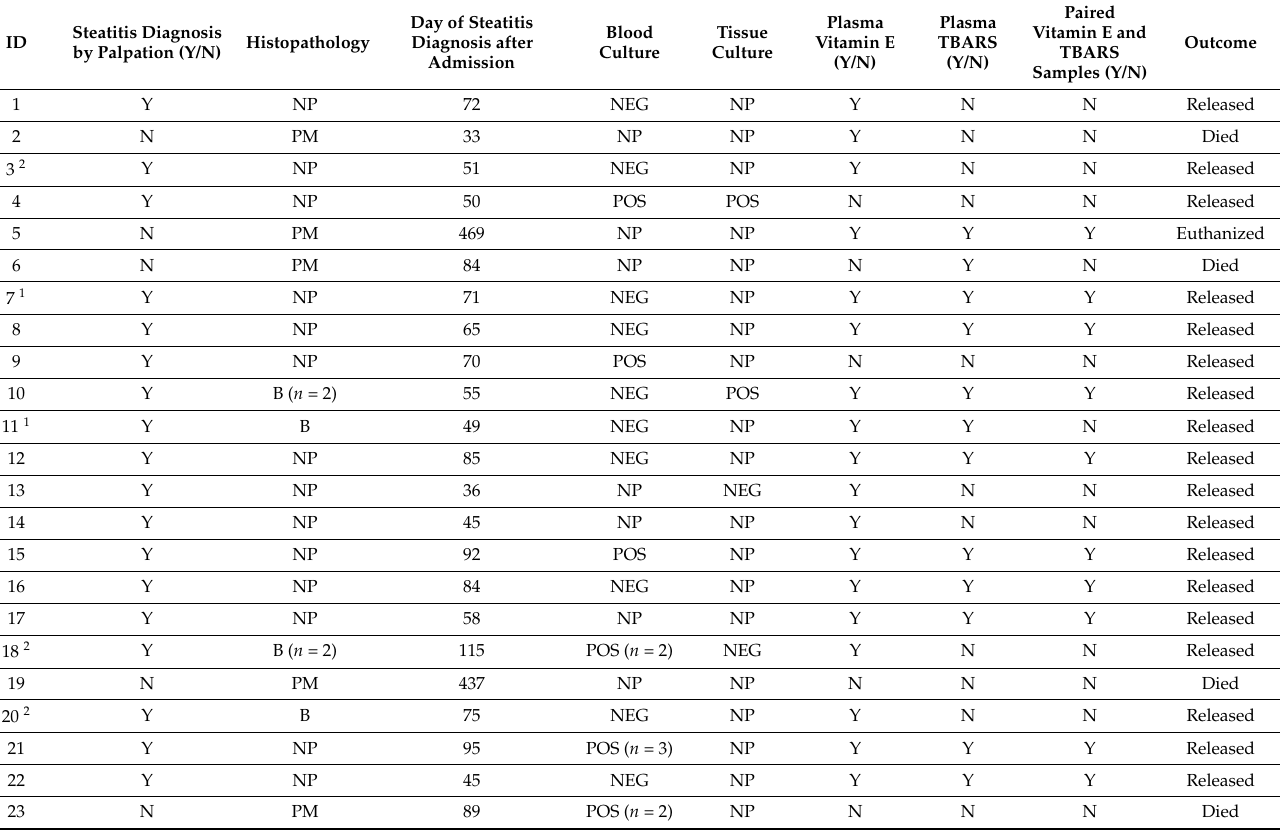
Table 1. Overview of cold-stunned Kemp’s ridley sea turtles ( Lepidochelys kempii ) admitted for rehabilitation with diagnosis of steatitis included in this study. NP = not performed; NEG = negative; POS = positive; B = biopsy; PM = post-mortem tissue